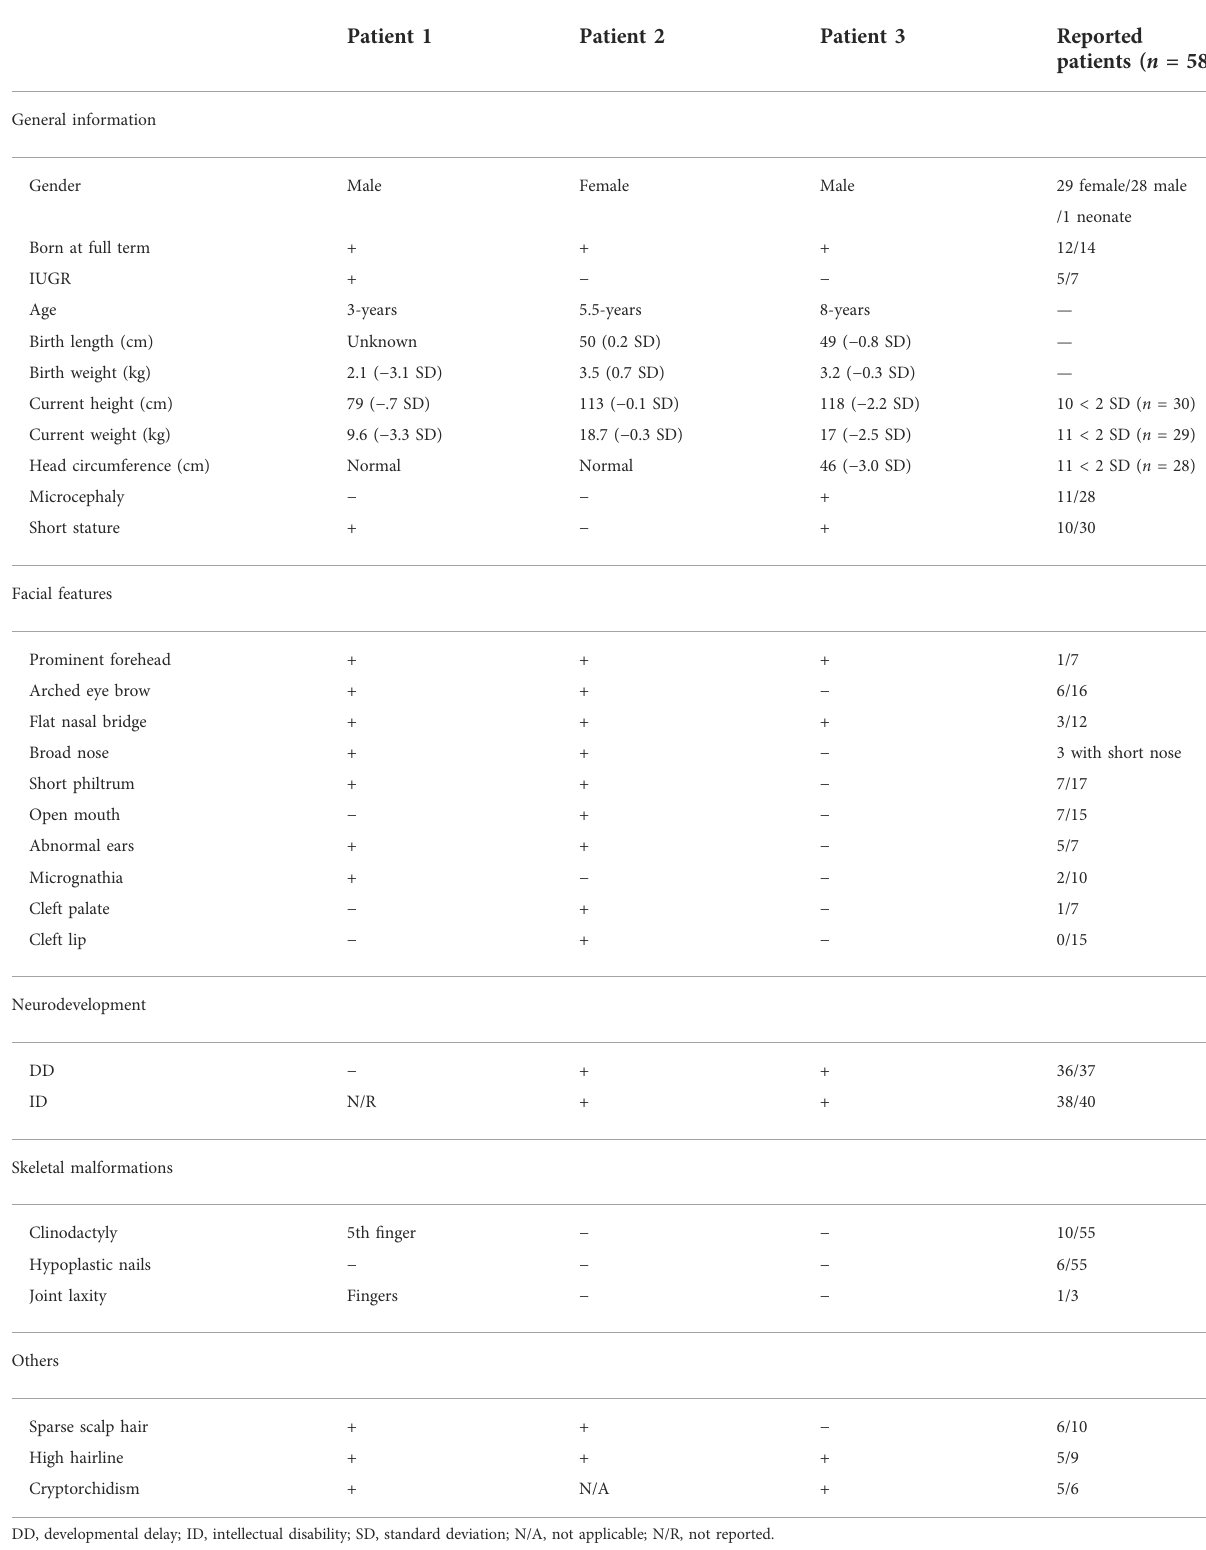
TABLE 1 Phenotypic comparison of our patient with reported